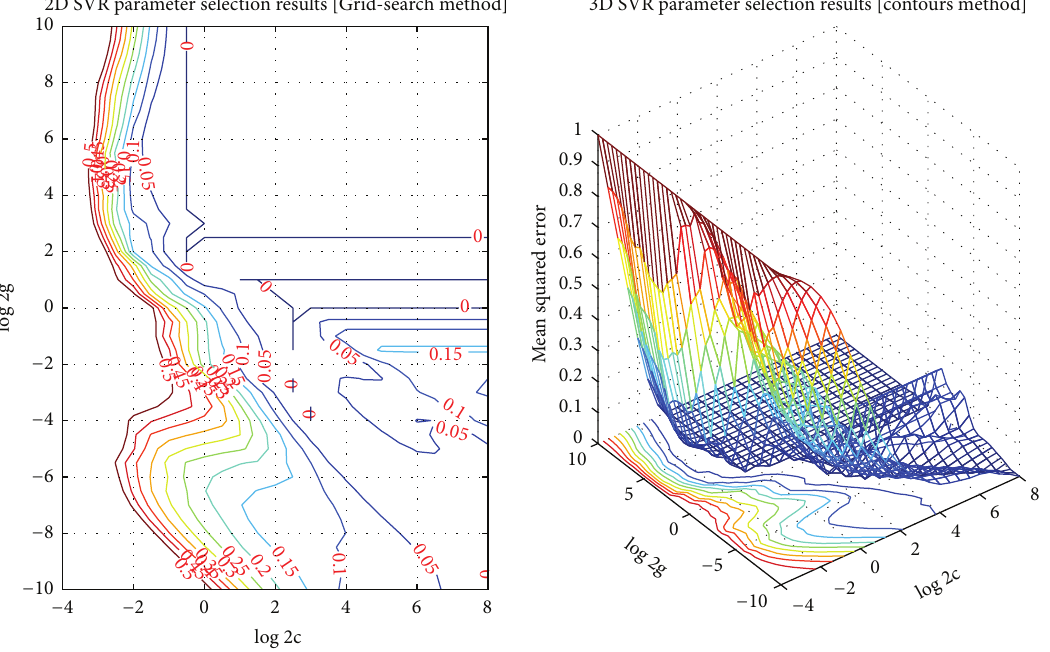
Figure 7: 2D and 3D parameter selection results. (Grid-search method and contours method, RBF).